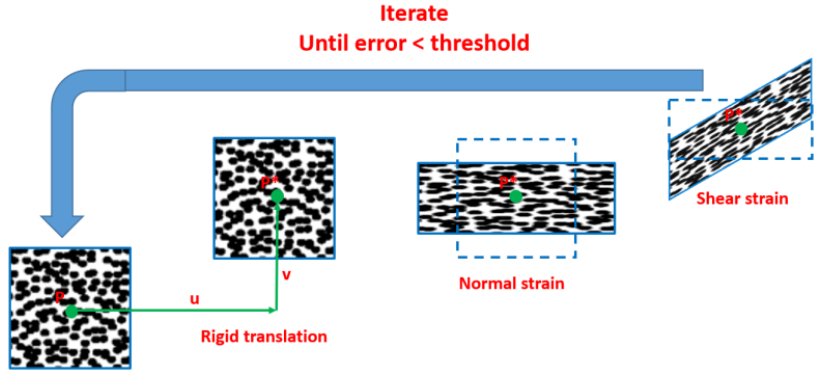
Figure 3. The steps of the iteration (on the basis of [41]).